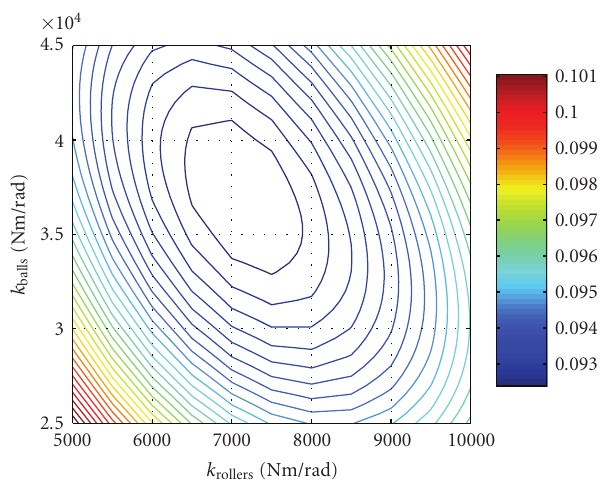
Figure 14: Quadratic error